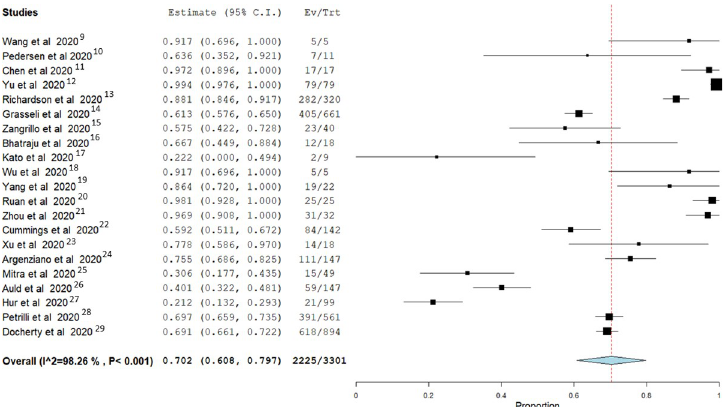
Fig 2. Forest plot of pooled analysis of mortality by random effect model in all studies of IMV with COVID 19 patients.